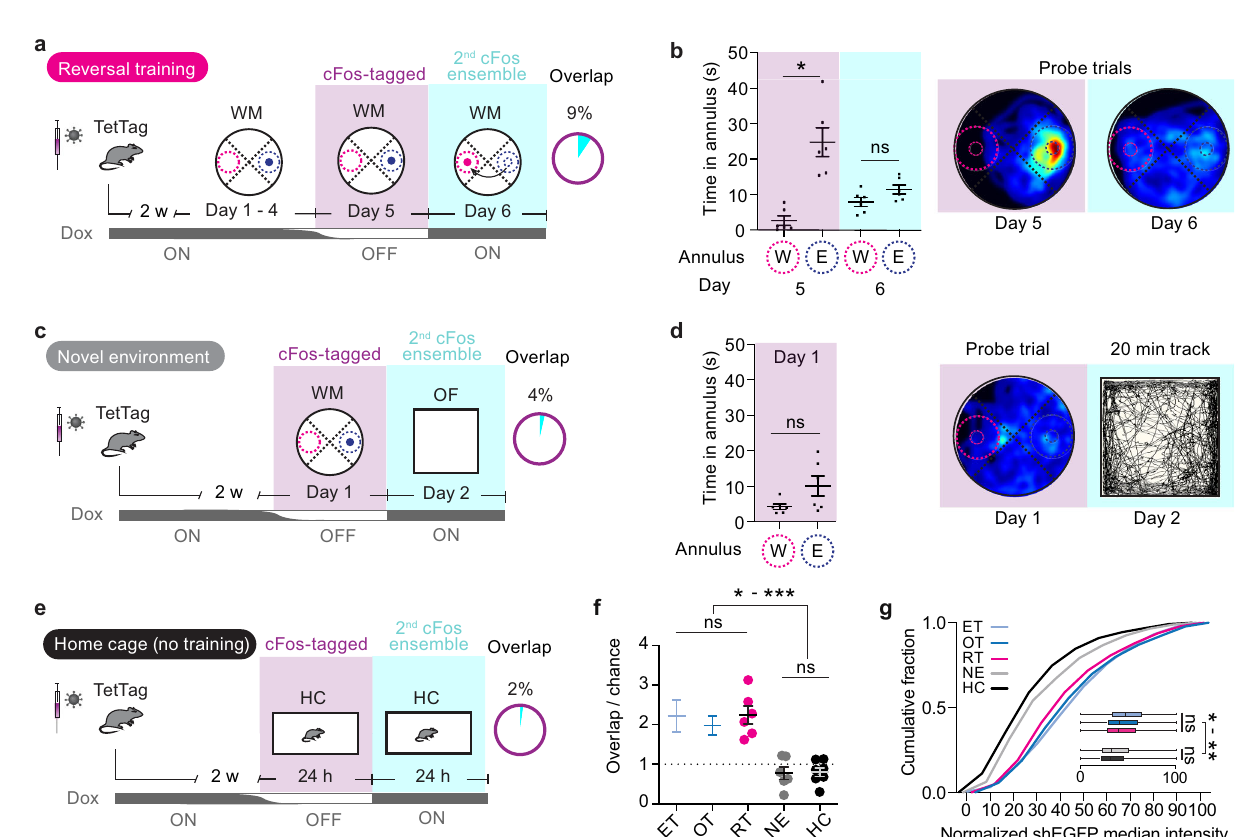
Fig.1|Behavioralperformanceinaspatialmemorytaskisnotre fl ectedbycFos ensemble overlap in the DG. a Water maze (WM) with the platform in east quadrant (E). Virtual 35cm diameter annuli for spatial accuracy analysis (E vs W). b Exemplary mouse swim paths during training trials. c WM learning (escape latency) over 6 training days (black line: average of all mice. days 1 – 2, n =12; days 3 – 6, n =6). Note the rapid learning during early training (ET, n =6 mice, * p =0.02) andlackofimprovementwhenovertrained(OT, n =6mice, n =0.98).Mixedeffects model with Š ídák ’ s multiple comparisons test. d Tagging method. In TetTag mice injected with AAV-TRE- mKate2 , cFos+ granule cells (GC) express mKate2 in the absence of Doxycycline (Dox), resulting in permanent fl uorescence (cFos-tagged, magenta). Left hemisphere: Nissl from the Allen Reference Atlas 70 . Nuclear fl uor- escenceidenti fi esrecentcFosexpression(2ndensemble,shEGFP,cyan).Overlapis thefractionofmKate2 + neuronsexpressingshEGFP. e ExperimentaltimelineforET mice and cFos overlap. f Time spent in annuli in probe trials on day 1 and 2 (ET